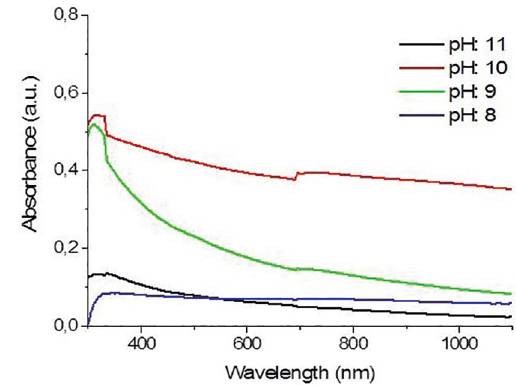
Figure 4. Transmittance and reflectance of MnSeO deposited at various pH levels